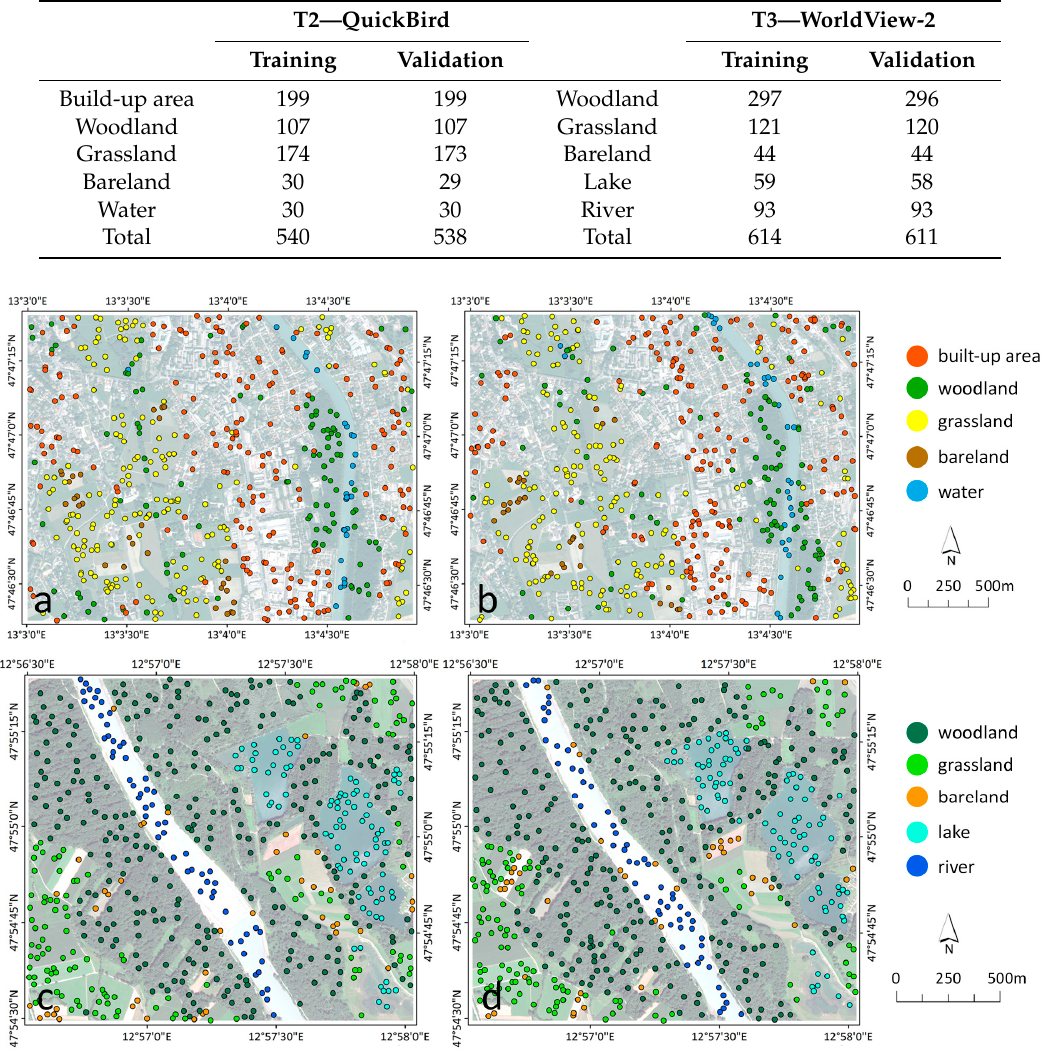
Table 3. Training and validation samples for T2 and T3 test areas.